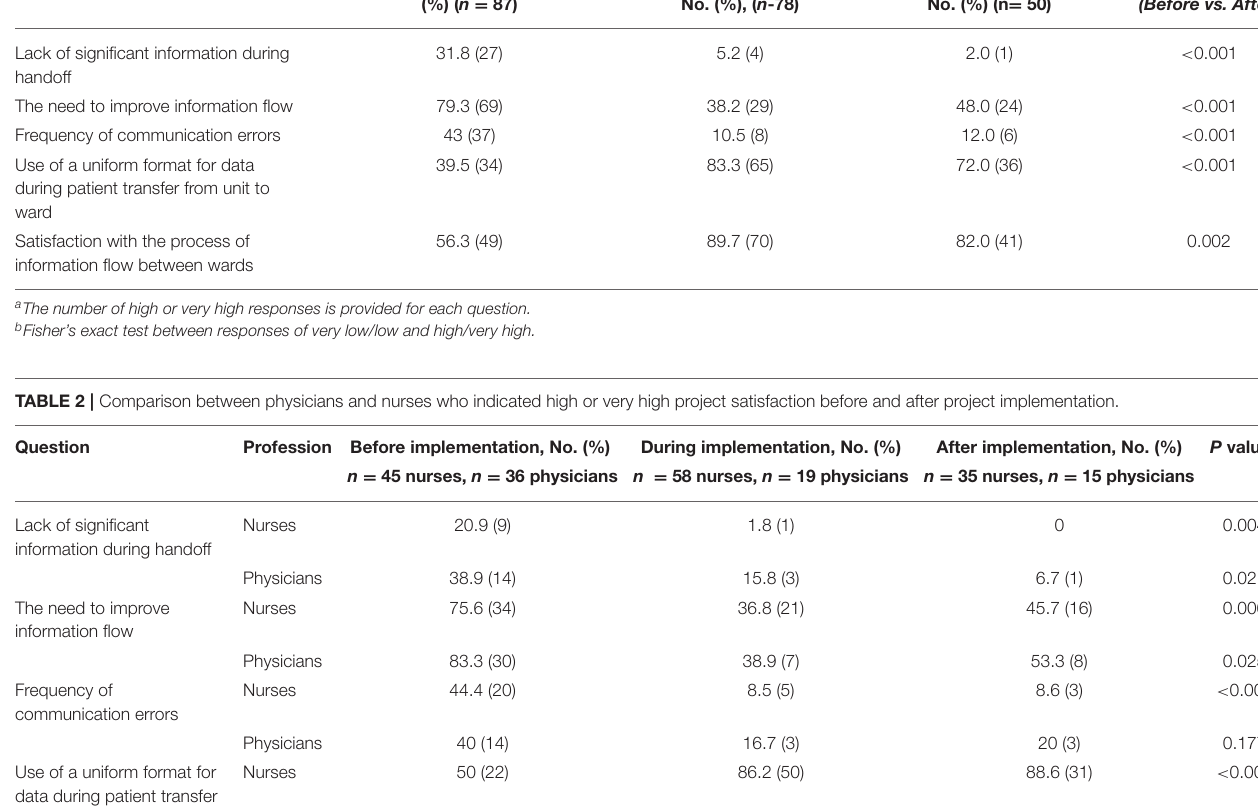
TABLE 1 | Evaluation of communication before and after project implementation. Question a Before implementation, No. During implementation, After implementation, P value b (%) ( n = 87) No. (%), ( n -78) No. (%) (n = 50) (Before vs. After) Lack of significant information during handoff